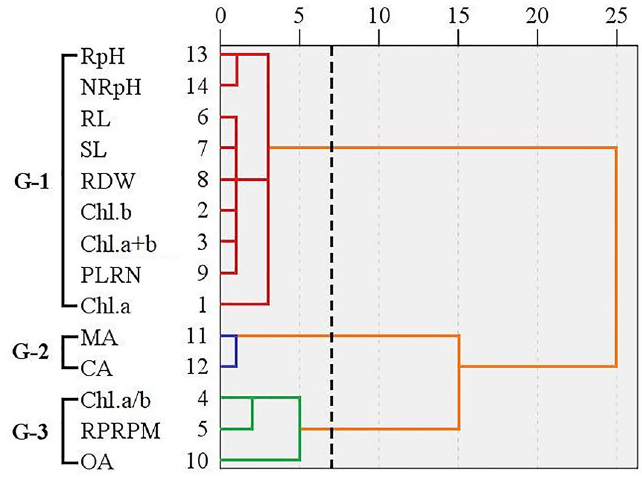
Figure 6. Dendrograms of cluster analysis showing the similarity for the test indicators of Masson pine family No. 35 and No. 79 exposed to the SAR at pH of 5.6, 4.5, 3.5, and